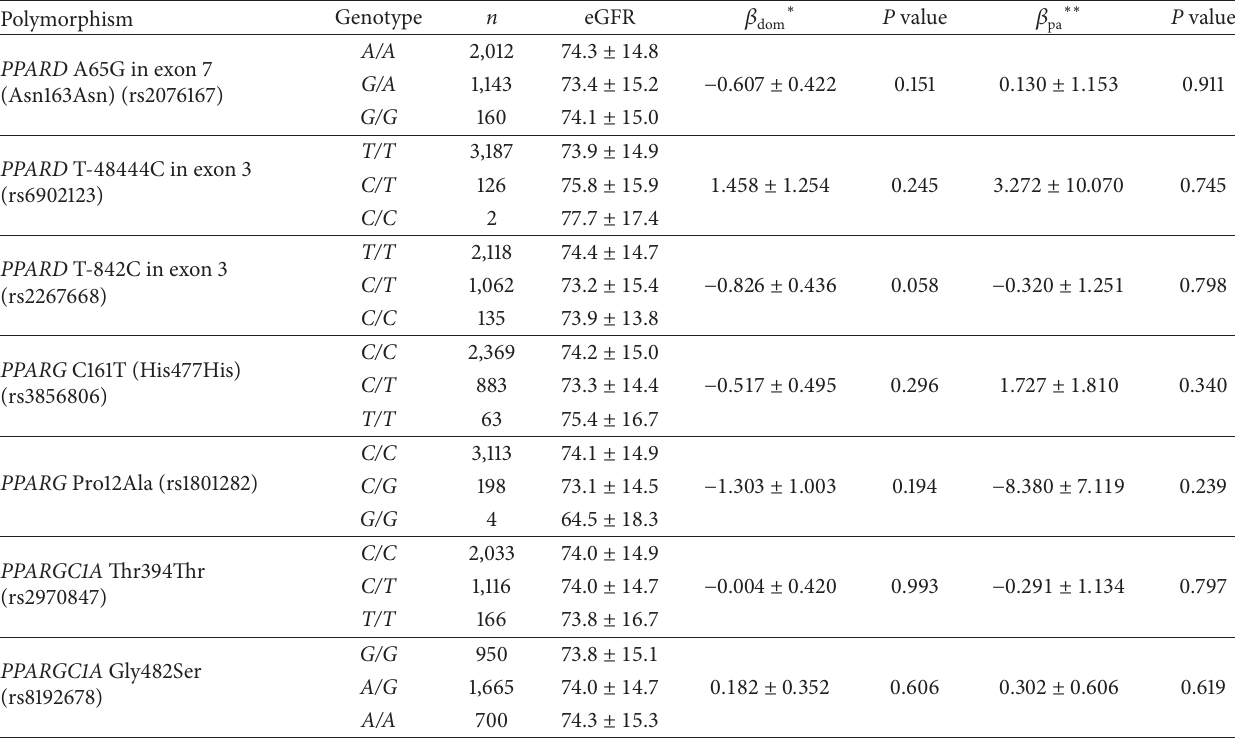
Table 3: PPARD , PPARG, and PPARGC1A polymorphisms and